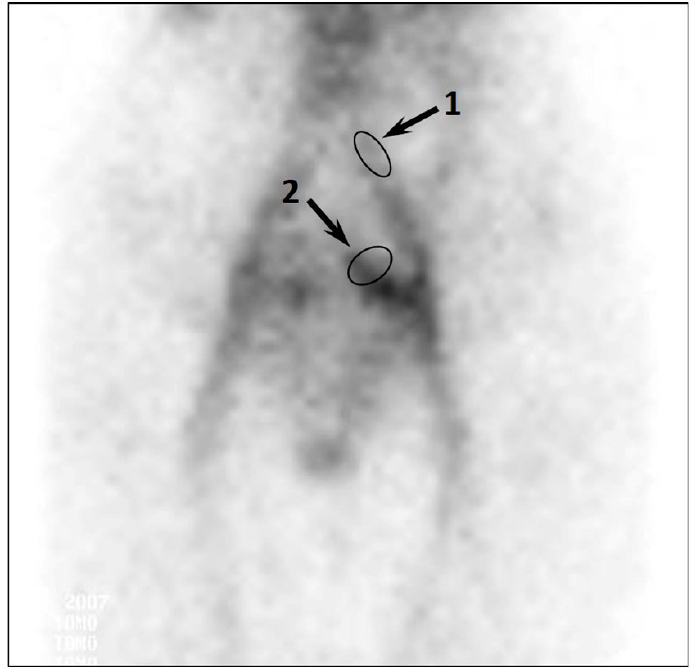
Figure 2. SPECT imaging of the pelvic veins of patient B. with symptomatic PeVD. A significant accumulation of labeled RBCs in the parametrial veins is observed. The arrows indicate the regions of interest: 1, “common iliac vein”; 2, “parametrial veins”. C PVC = 1.6.